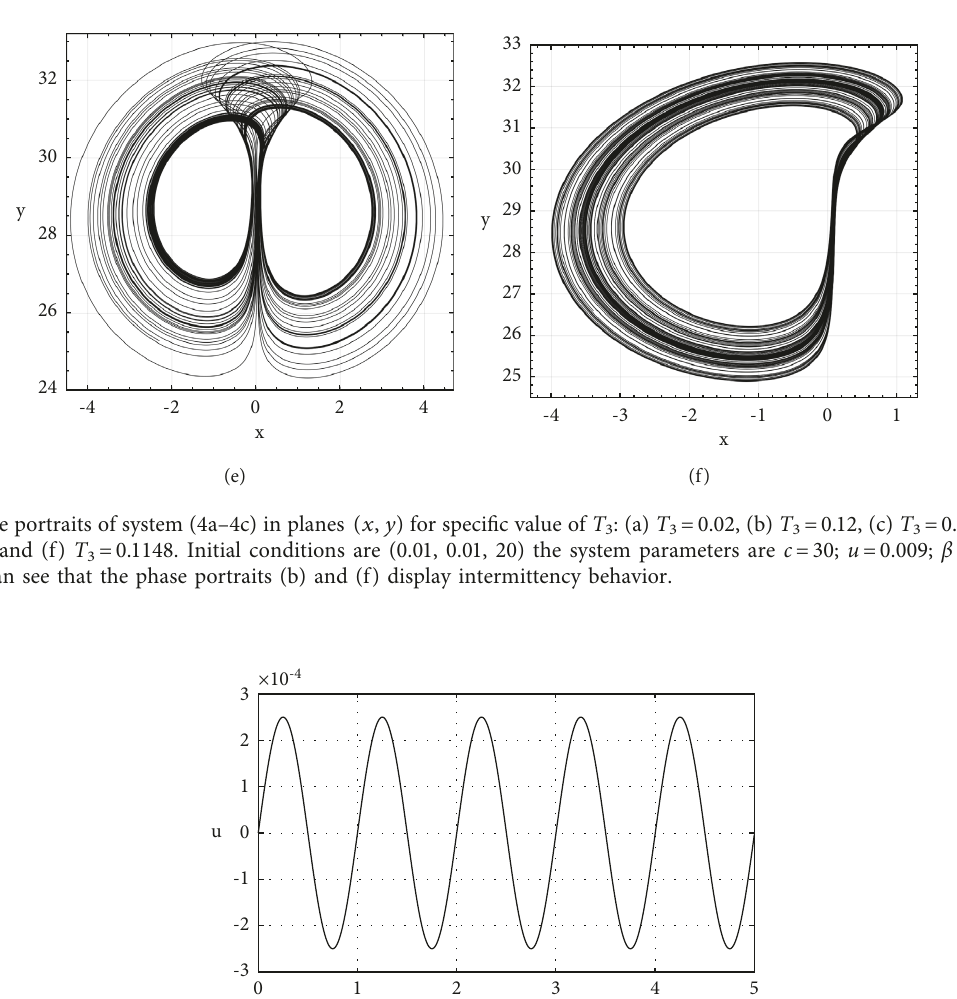
Figure 7: Sinusoidal waveform of the load torque T